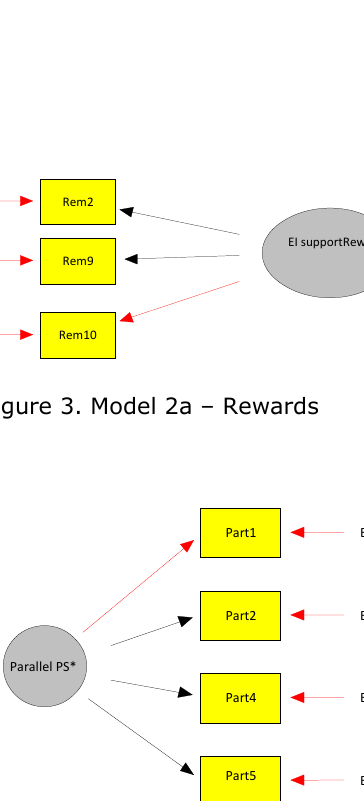
Figure 1. Model 1a – Rewards Figure 2. Model 1b – Empowerment